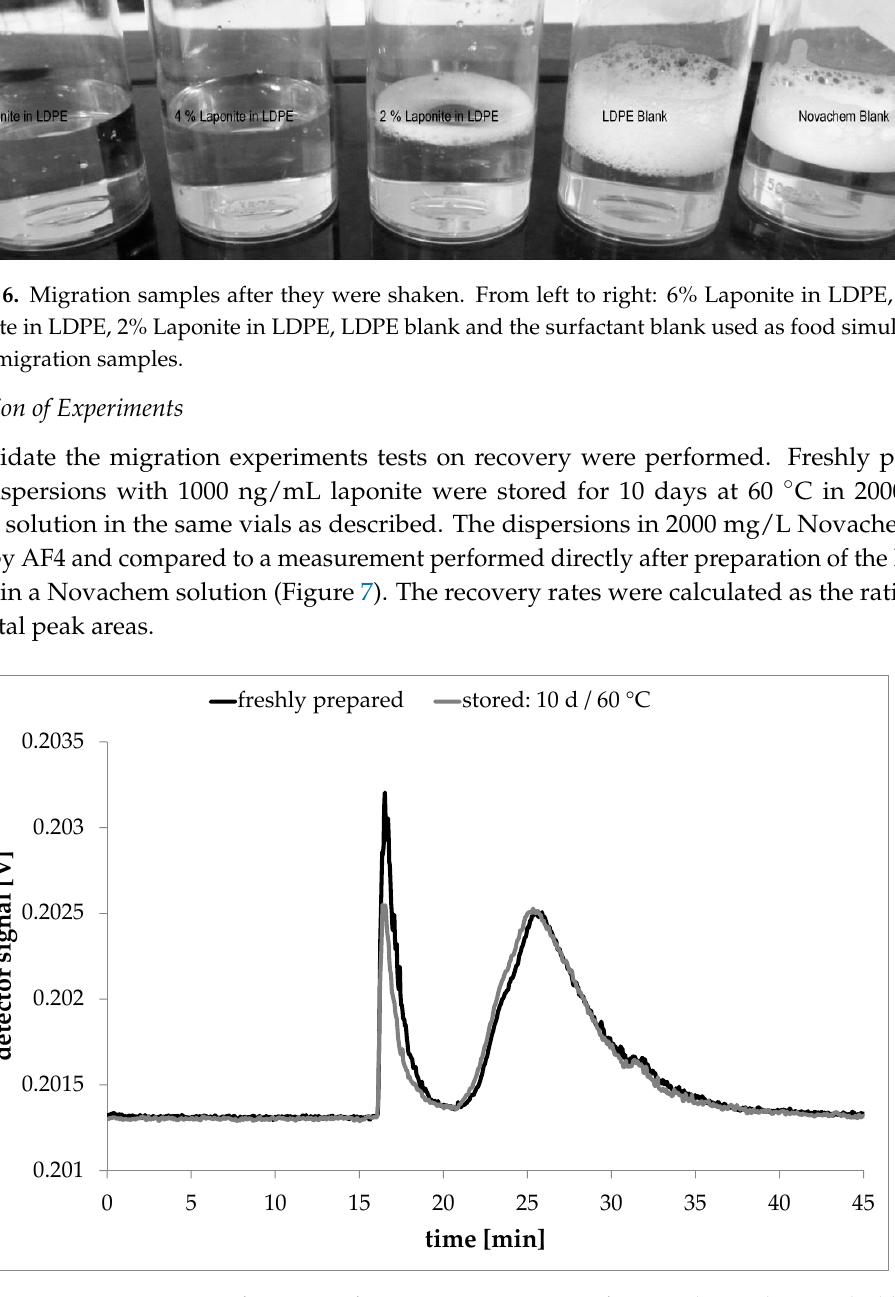
Figure 7. Recovery experiment for 1000 ng/mL Laponite in 2000 mg/L Novachem solution. The black curve is the fractogram of a fresh dispersion; the red curve is the fractogram of the same sample after 10 days at 60 °C (signals of the 68° detector).